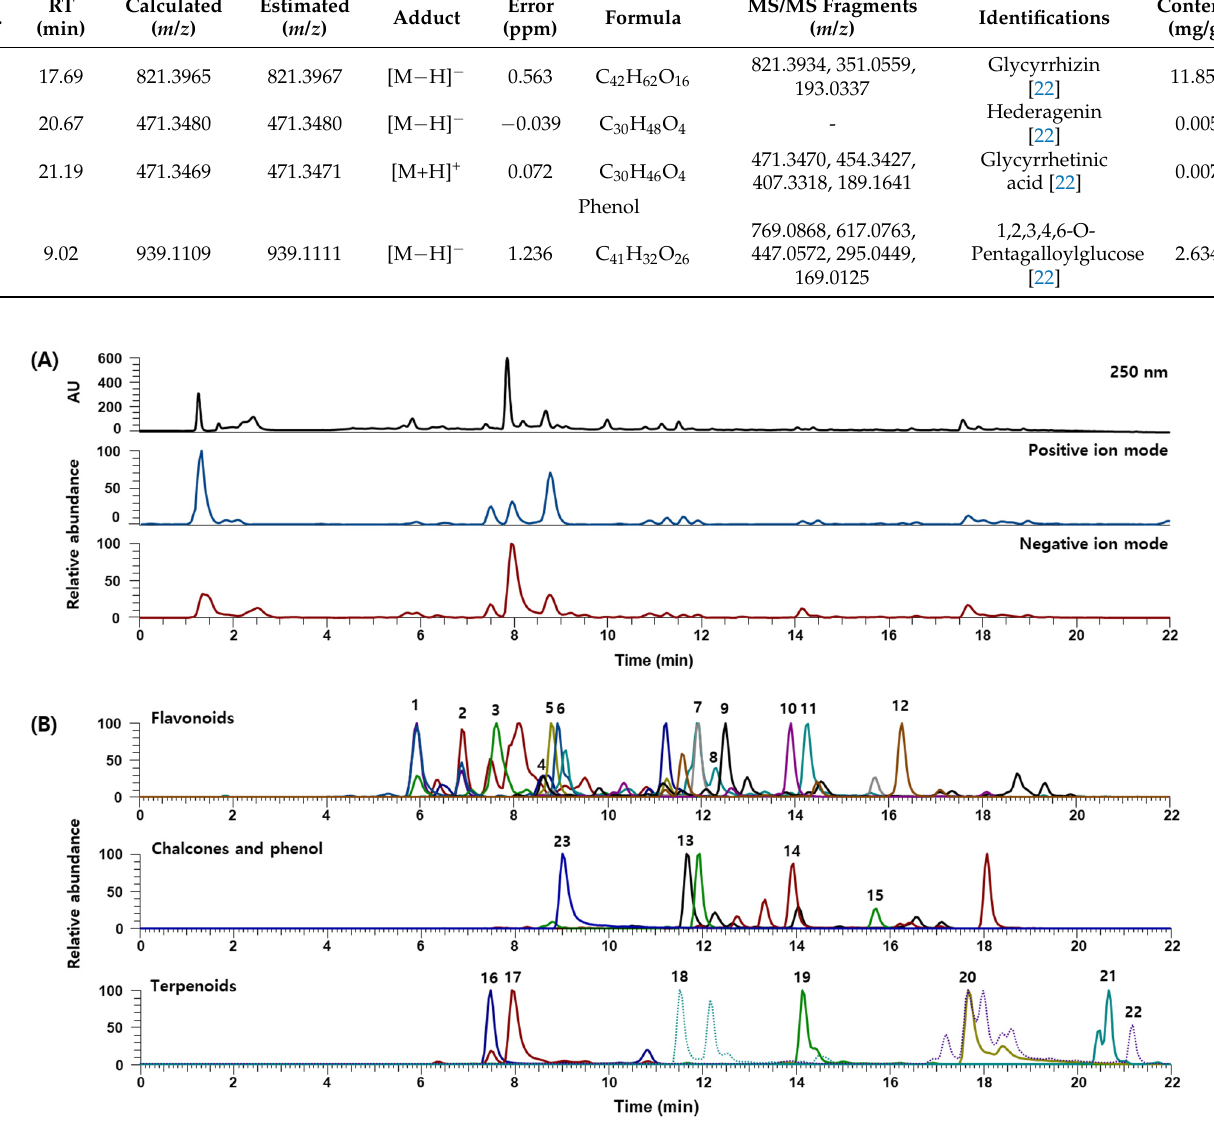
Figure 1. UPLC-DAD-MS/MS analysis of JGTW. ( A ) UV and base peak ion chromatograms of JGTW and ( B ) extracted ion chromatogram of the identified phytochemicals in JGTW. 1: catechin; 2: vicenin-2; 3: schaftoside or isoschaftoside; 4: